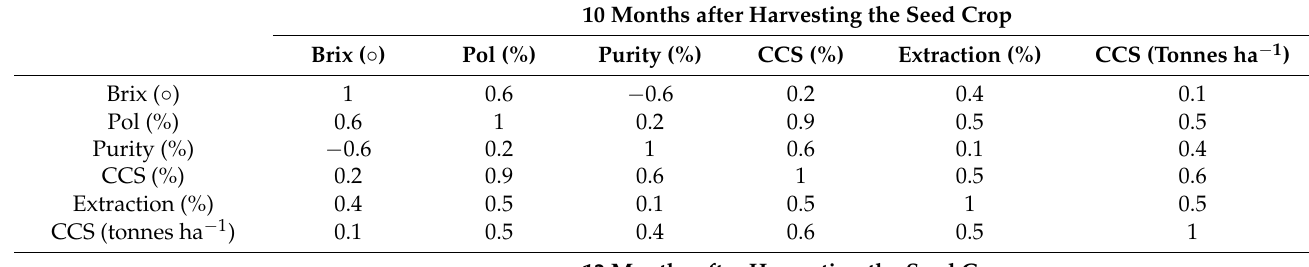
Table 8. Correlations between sugarcane quality parameters 10 and 12 months after harvesting the seed crop. 10 Months after Harvesting the Seed